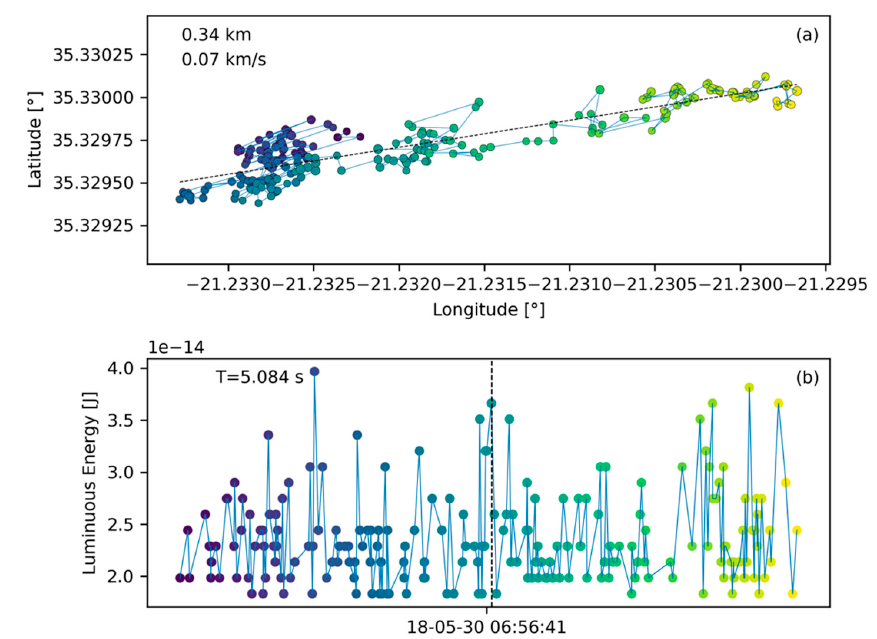
Figure 9. A false positive detected by the algorithm. Ground track is shown in plot ( a ) together with a least-squares fit line. The ground track exhibits considerable jitter relative to the line approximation. Plot ( b ) shows the energy deposition profile over time.